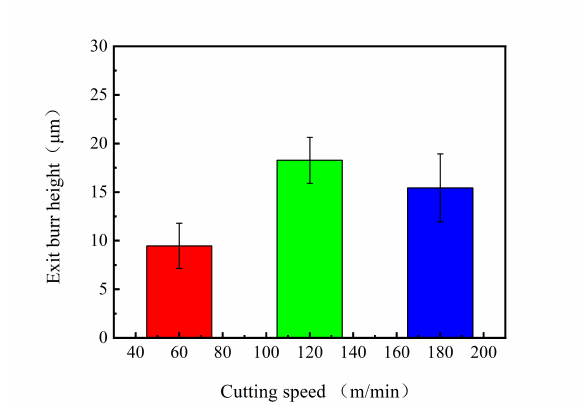
Fig. 7. Effect of the v c on exit burr height (f=0.15 mm/r)